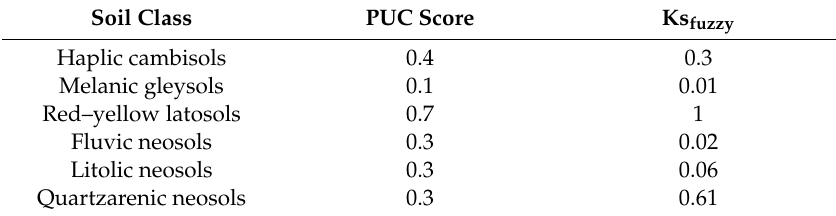
Table 8. Soil classes and respective Ks Fuzzy values. The scores of groundwater recharge parameter were set up by the PUC method in the Pandeiros River basin